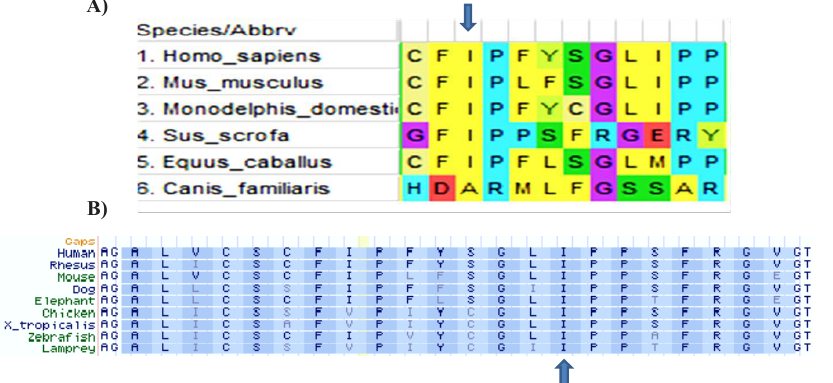
Figure 2. (A) The Conserved Region Contains Isoleusin at Position 148 in PNPLA3 Protein and (B) The UCSC Database Demonstrating High Conservation of Isoleusin at Position 148 of PNPLA3 protein. Note . PNPLA3: Patatin-like phospholipase domain-containing 3. MEGA X software was applied to perform ClustalW multiple sequence alignment. The amino acid sequences of PNPLA3 protein in organisms such as Homo sapience, Mus musculus, Monodelphis Domestica, Sus scrofa, and Equus caballus showed that its position is significantly